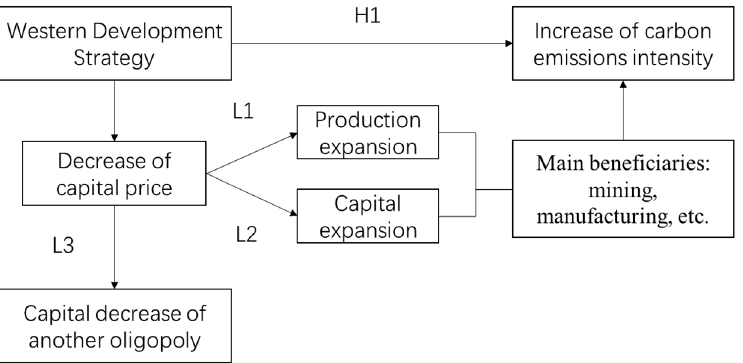
Figure 1. Research